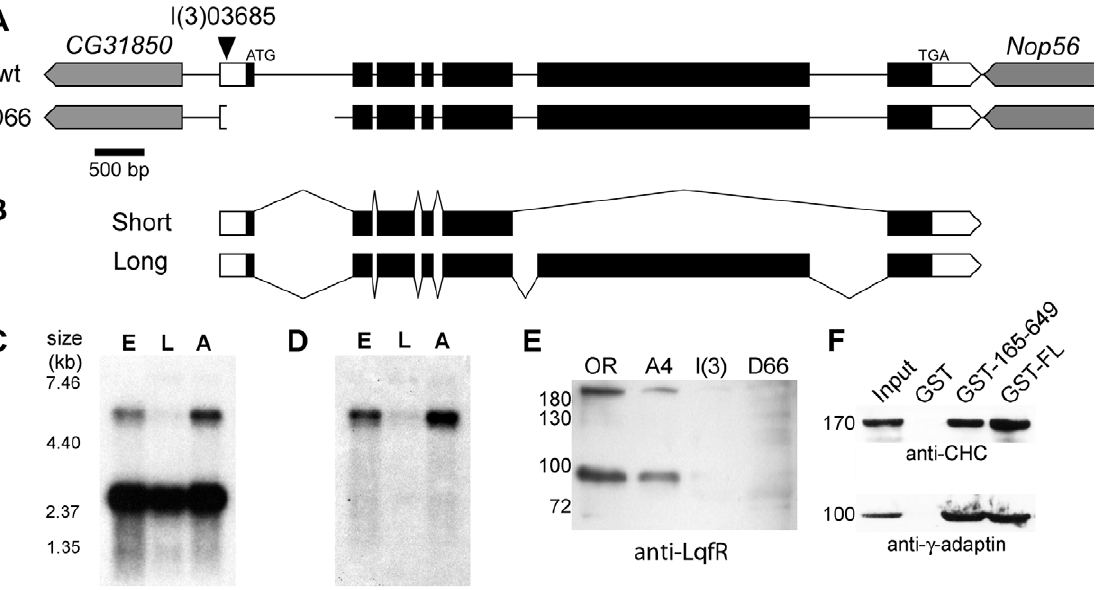
Figure 1. Characterization of Drosophila liquid facets-Related. (A) Genomic region of lqfR , based on FlyBase release FB2008_07. lqfR is on the right arm of chromosome 3 and is oriented 5 9 to 3 9 towards the telomere. It occupies 7.7 kb and is flanked at the 5 9 end by CG31850 and on the 3 9 end by Nop56, both which are on the opposite (-) strand. The ATG-Start and TGA-Stop codons for the small splice product are shown. Within lqfR , white boxes represent UTR and black boxes represent ORF. Gene orientation is indicated by the pointed bars. The location of the P element insertion in lqfR 03685 is shown by the arrowhead. The lqfR D66 deletion is 1.1 kb. Scale bar, 500 bp. (B) The structure of the two predicted isoforms of lqfR is shown. Northern blots of embryonic, larval and adult mRNA probed with probes to lqfR exon 3–5 (C) and exon 6 (D). Marker sizes (in kb) are shown. (E) lqfR D66 mutants have undetectable amounts of LqfR protein. Western blot of lysates from 1/10 homozygous wild-type Oregon R (OR), lqfR + A4 (A4), lqfR 03685 (l(3)), or hypomorph lqfR D66 (D66) early pupae detected with crude rat anti-LqfR 3148-2 antiserum. (F) GST-pull down assays. GST alone, or GST fusions of full-length LqfR (GST-FL) or amino acids 165–649 (GST-165–649) were incubated with a soluble rat brain extract. Specifically bound proteins were detected with antibodies against clathrin heavy chain (CHC) or c -adaptin. An aliquot of 1/10 of the brain lysate input was processed in parallel. M r of protein standards is shown in kDA (E, F).